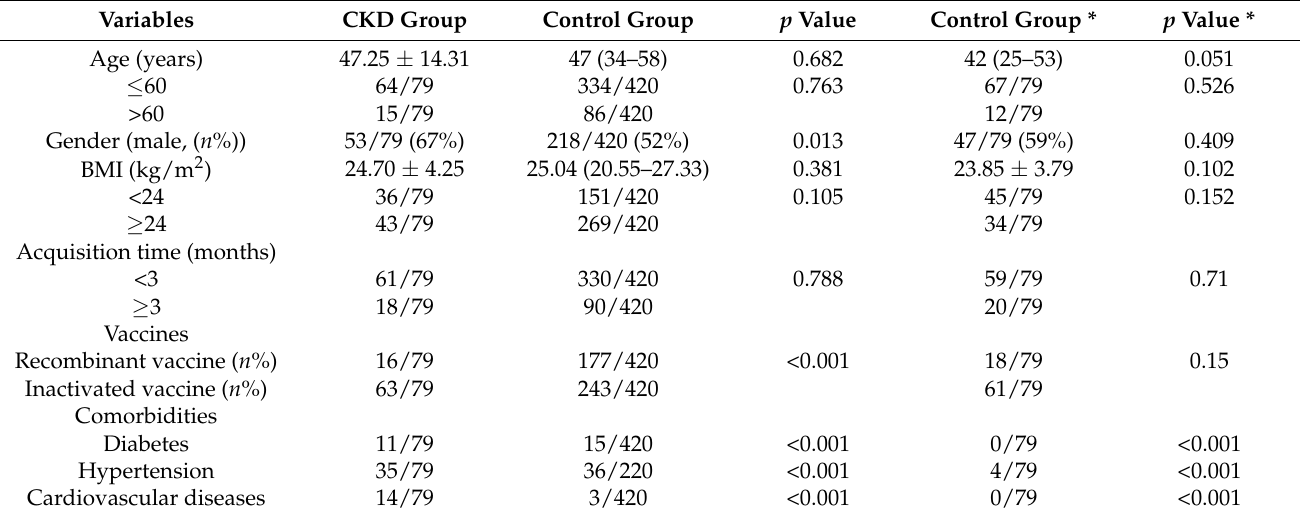
Table 1. Baseline characteristics of the CKD patients and healthy controls.